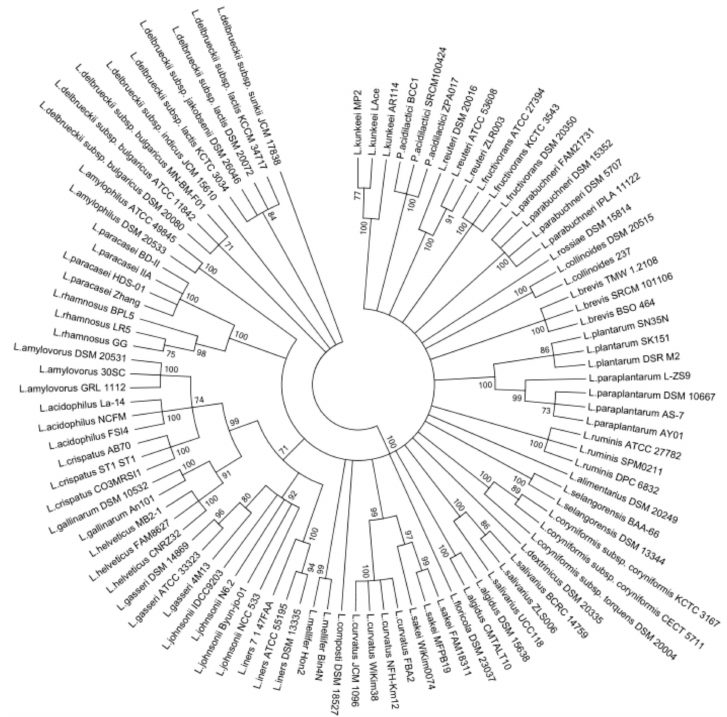
Figure 1. Phylogenetic tree of Lactobacillus on the basis of groEL gene sequences by maximum likelihood (ML) analysis method. Bootstrapping with 1000 replicates, and bootstrap values over 70% were shown on the